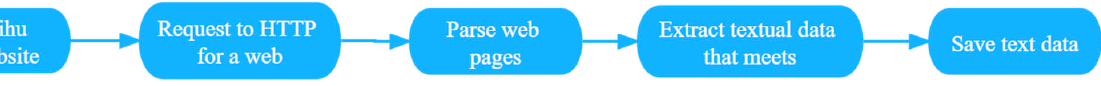
Figure 1. Basic principles of a web crawler.